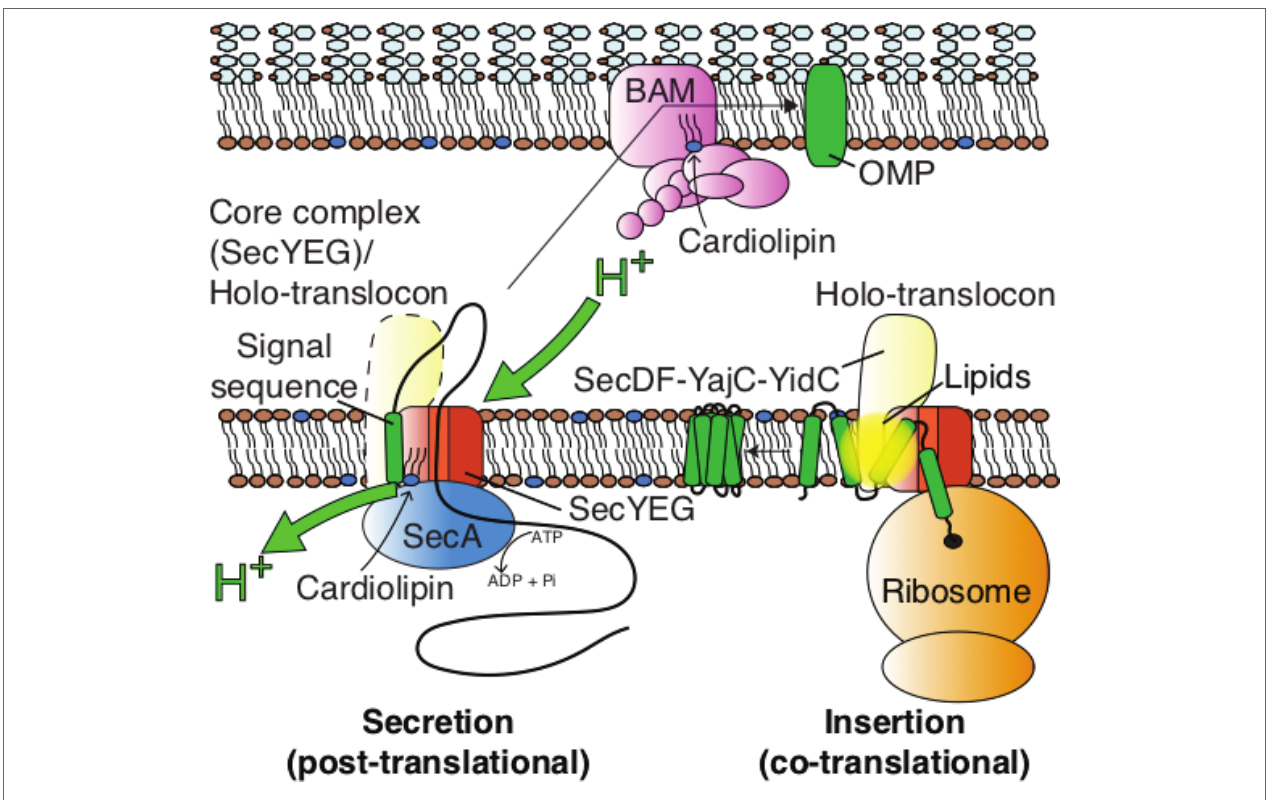
FIGURE 1 | Pathways for protein transport across and into the Gram-negative inner membrane and further across the periplasm for outer-membrane insertion and folding. The figure also highlights the action of lipids on the SecYEG-SecA complex (see Figure 3 ), the holo-translocon (HTL), and the BAM